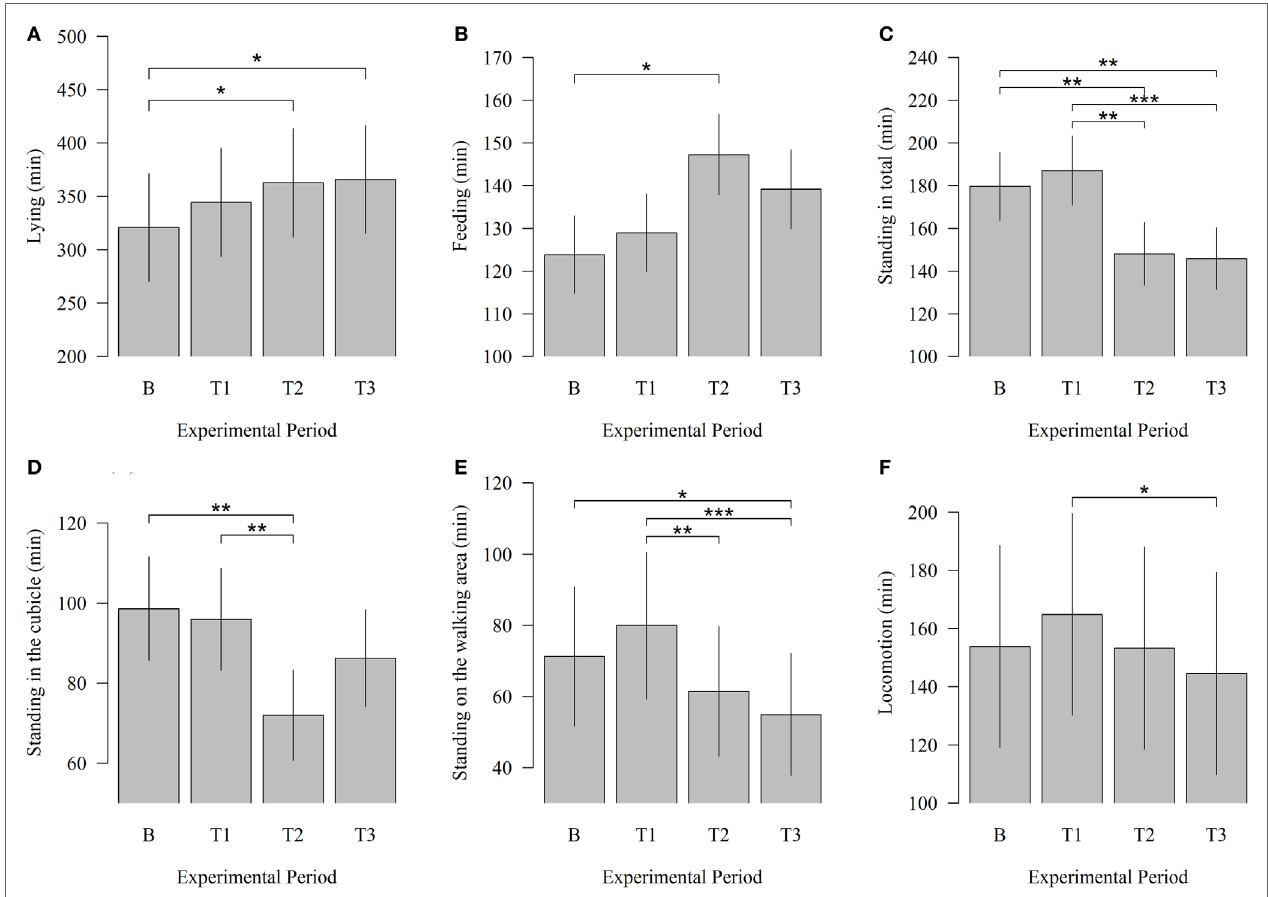
FigUre 4 | effects of the robot scraper on the behavior of dairy cows . (a) Times cows spent lying, (B) feeding, (c) standing in total, (D) standing in the cubicle, (e) standing in the walking area, and (F) walking for the baseline measurement (B) and test measurements (T1, T2, T3) based on a daily observation time of 14 h. Vertical lines indicate SEMs and asterisks significant differences between means of the different experimental periods (* P < 0.05, ** P < 0.01, *** P <